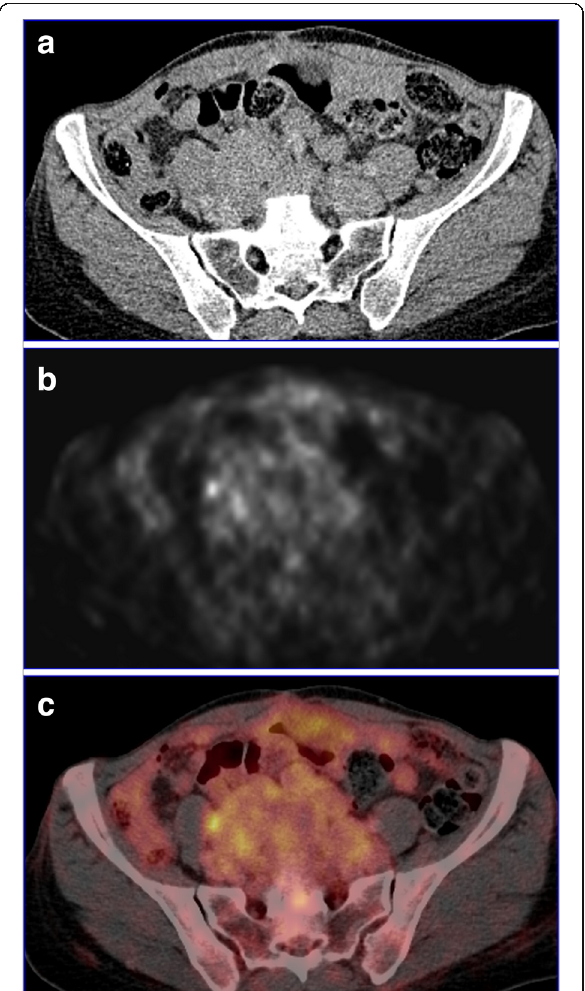
Fig. 1 Recurrent ovarian cancer. a Axial contrast-enhanced CT, b FDG PET, and c PET/CT images show multiple confluent soft tissue heterogeneous masses with increased FDG uptake (max. SUV ~